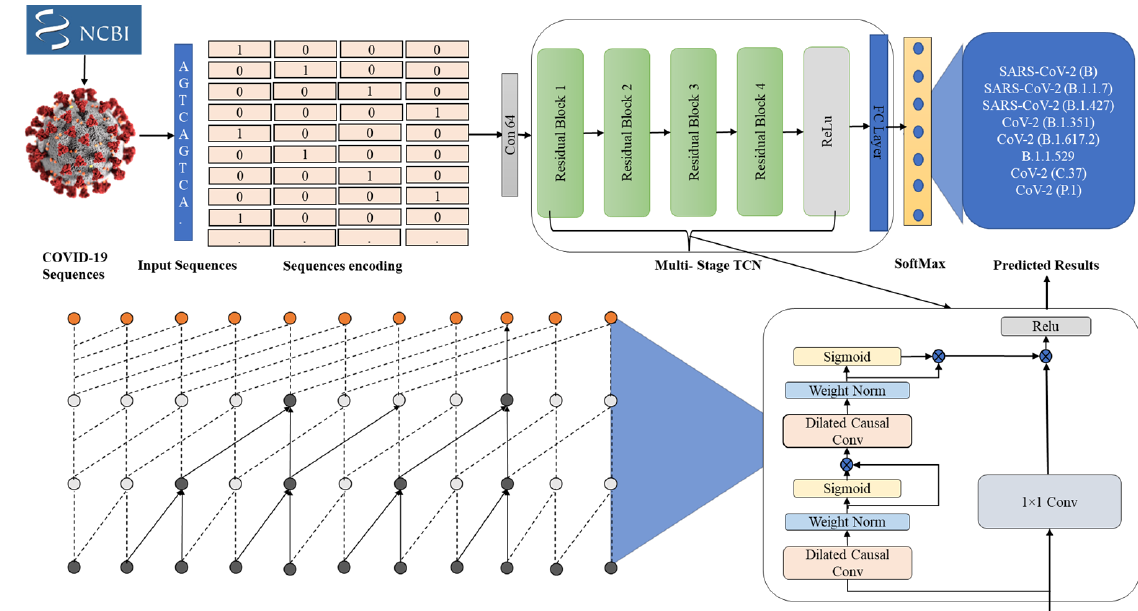
Figure 1. The proposed framework for COVID-19 virus variant classification.